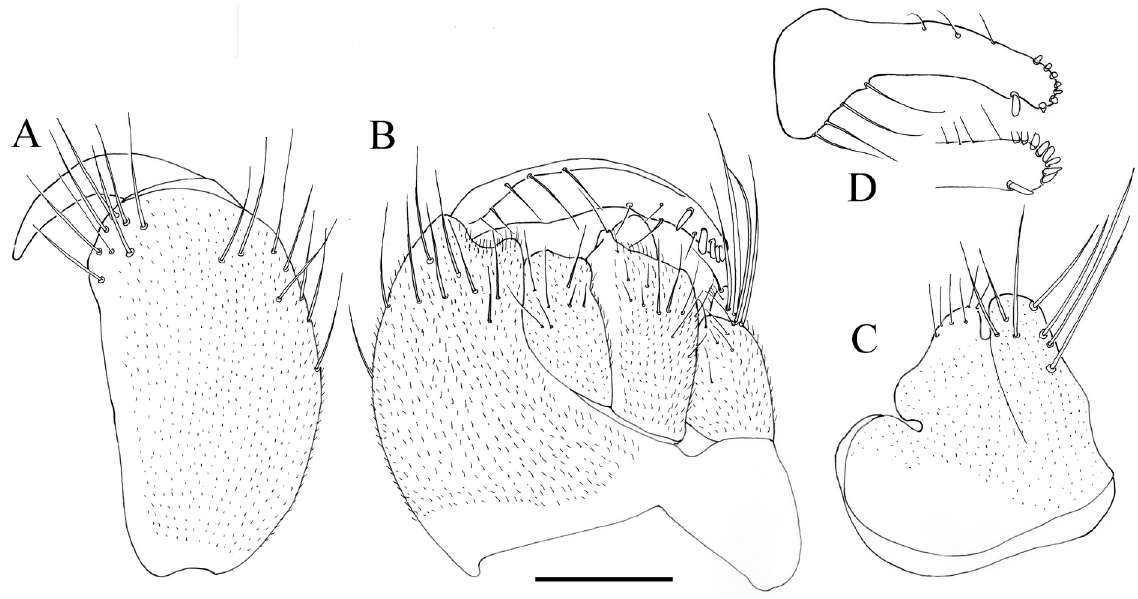
Fig. 8. Terminalia of Tachydromia iberica (Arias, 1919) from Portugal, Leiria, Porto de Mós (RBINS). A . Right surstylus and right epandrial lamella. B . Epandrium with cerci. C . Left epandrial lamella and left surstylus. D . Right surstylus. Scale bar: 0.1